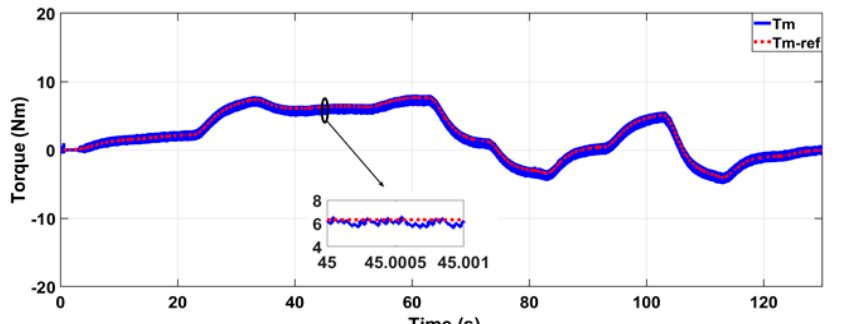
Figure 6. Motor speed and reference.